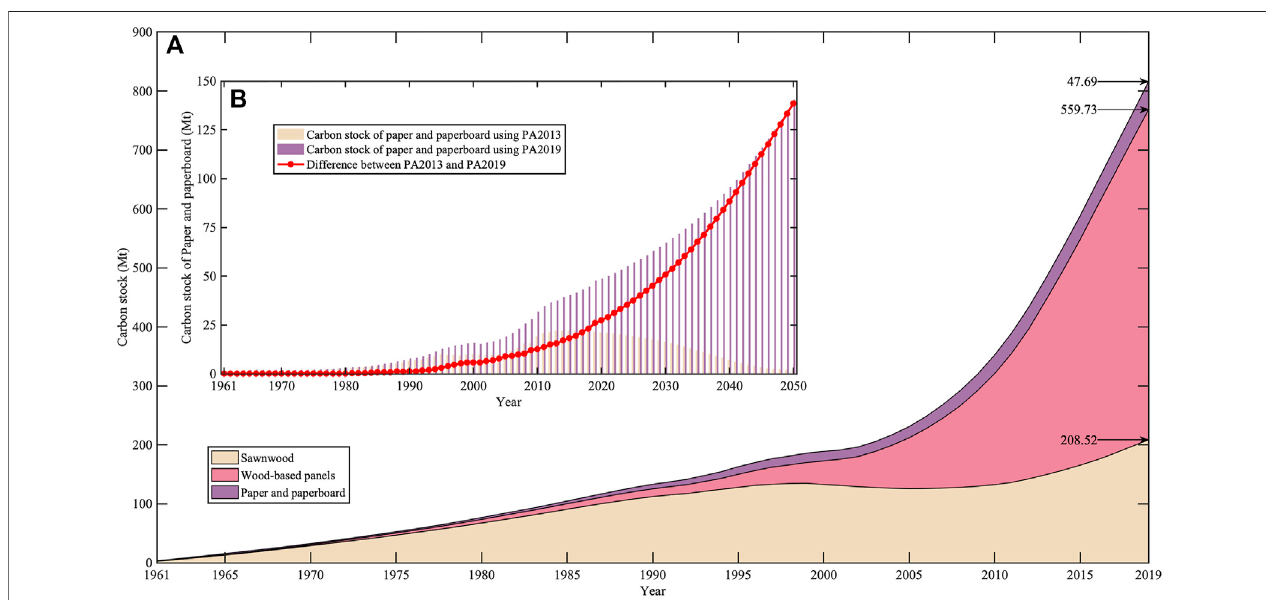
FIGURE 3 | (A) Carbon stock of harvested wood products in China from 1961 to 2019 using PA2019. (B) Comparison of the carbon stock of paper and paperboard in China from 1961 to 2050 using PA2013 and PA2019. The three arrows and numbers on the right side of the fi gure represent the carbon stock of three HWP semi- fi nished products, respectively.